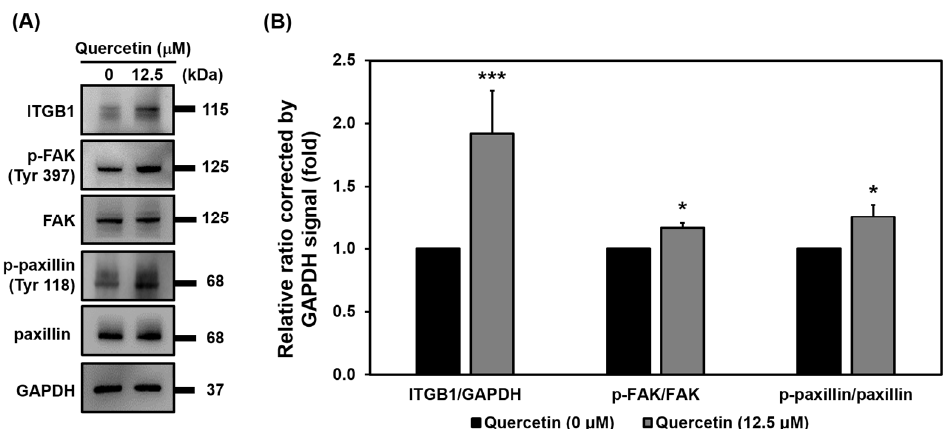
Figure 9. Quercetin regulated myoblast migration through the ITGB1 signaling pathway. C2C12 cells were grown to 80% confluency density in a 24-well plate. The cells were treated without or with quercetin (0, 12.5 μ M) and cultured in DMEM medium containing 2% horse serum for 15 h to promote cell migration. Western blot analysis was used to investigate relative involvement of the related proteins in cell migration with GAPDH used as internal control. ( A ) Western blot images of ITGB1, p-FAK, FAK, p-paxillin, and paxillin involvement. ( B ) Bar graph shows relative protein expression of related proteins. Data are expressed as the mean ± SD of three independent biological repeats ( n = 3). The differences between the quercetin-treated group and controls were significant, * p < 0.05, *** p < 0.001.